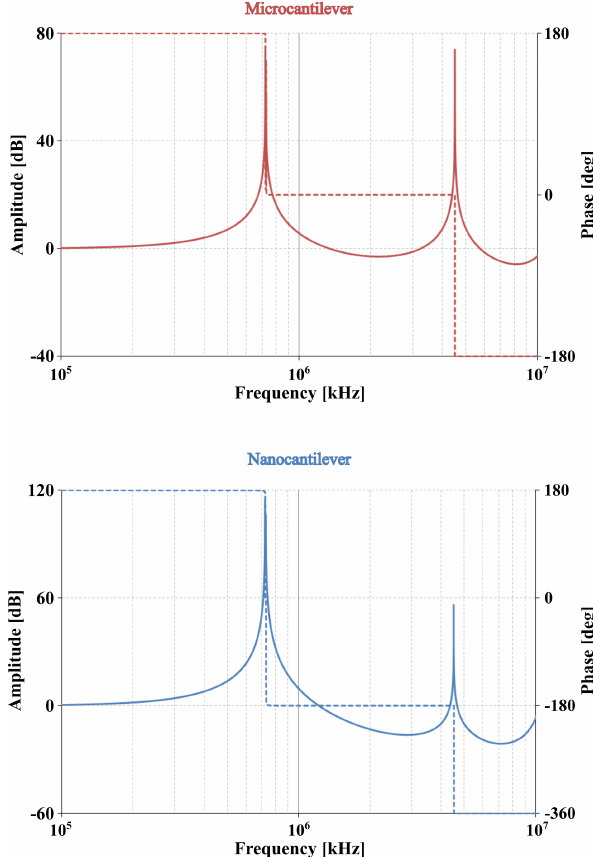
Figure 18. Bode plot for both cantilevers of the coupled system of Fig. 17 represented by a discrete beam model, depicting several resonance modes.